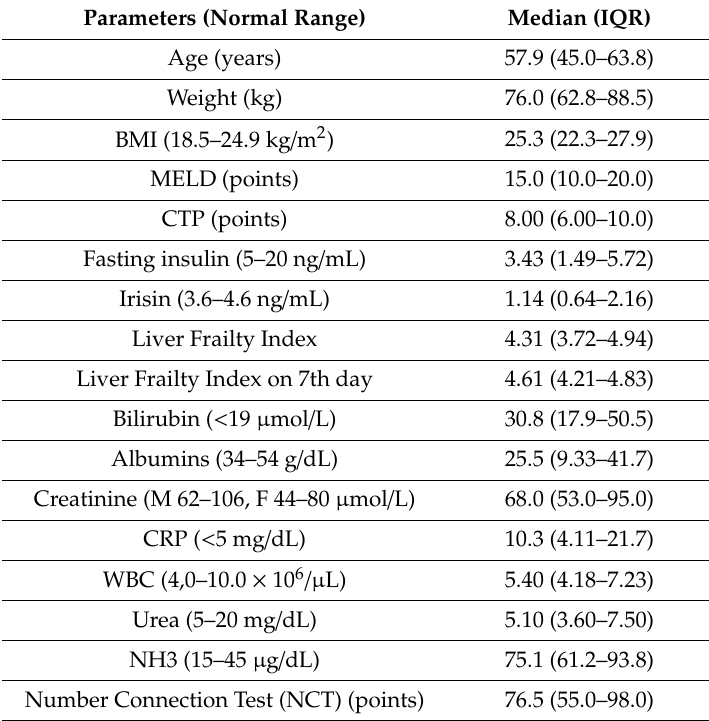
Table 1. General characteristics and basic laboratory tests of cirrhotic patients.